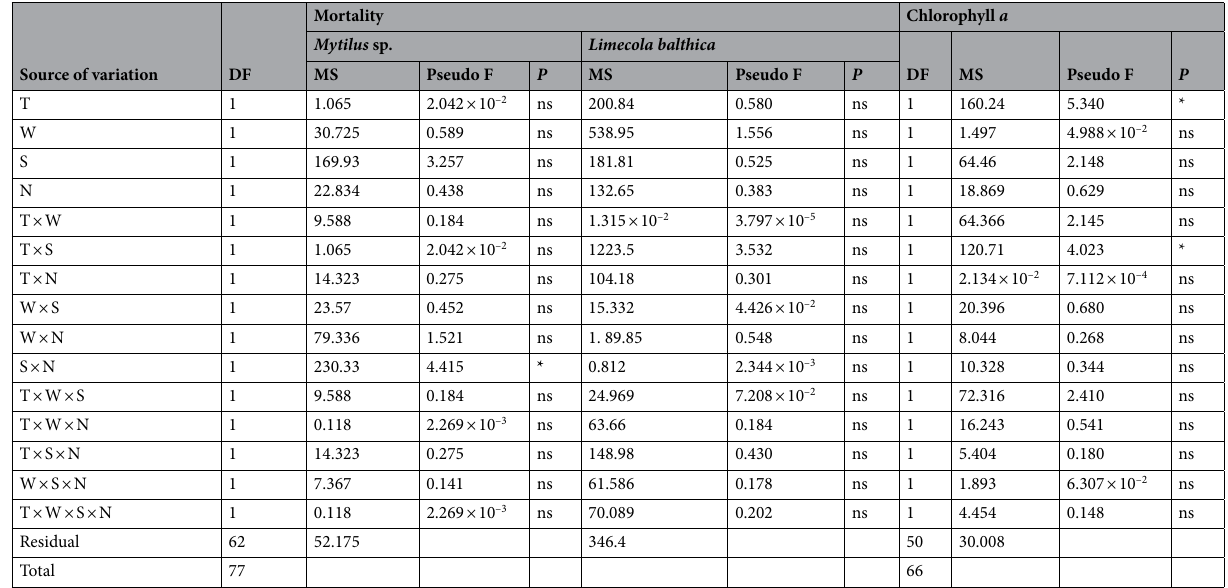
Table 2. Results of PERMANOVA analyses investigating the effect of exposure time (T), temperature (W), salinity variation (S) and nutrient enrichment (N) on mortality levels in the common mussel, Mytilus sp. and the Baltic clam, L. balthica and on chlorophyll a concentration in sediments. The factors temperature (W), salinity variation (S) and nutrient enrichment (N) were set as fixed. Details are provided for degree of freedom (DF), mean square (MS), Pseudo-F and probability level ( P